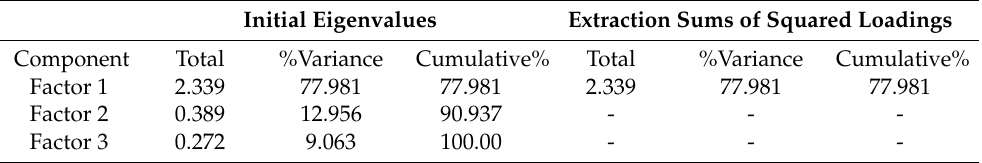
Table 3. Total variance explained in the principal component